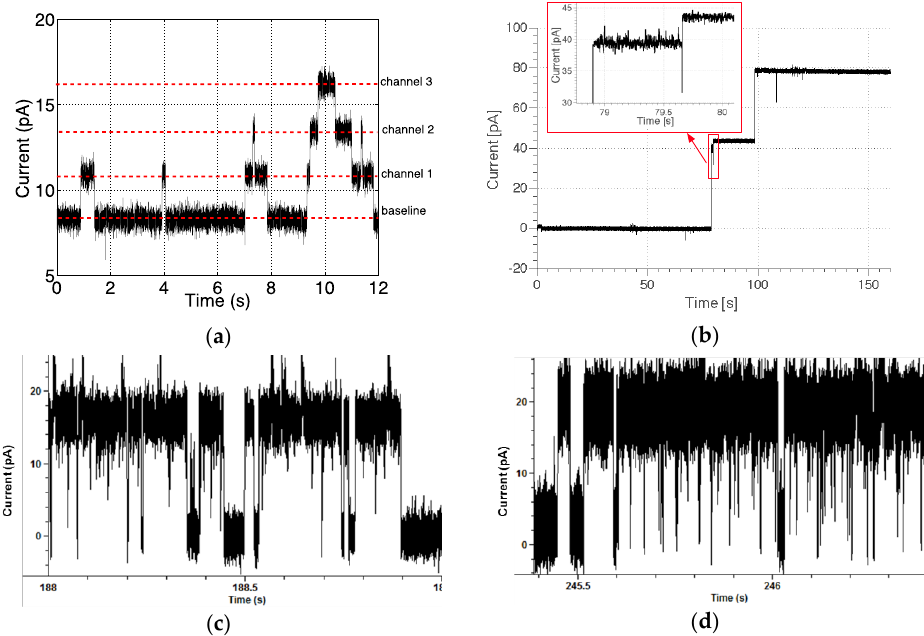
Figure 14 . ( a ) Data from gramicidin-A channels. Applied potential = 100 mV and the acquisition has been performed at 625 Hz; ( b ) Current trace showing the insertion of two α-HL nanopores. Experiments performed with 2.5 μg/ml of α-HL protein in 1 M of KCl solution. Acquisition performed at 200 pA range with post-processing filtering at 1.25 kHz; ( c ) KcsA recording at 125 mV with data filtered at 5 kHz and ( d ) 10 kHz. The buffer was 150 mM KCl, pH 4.0.